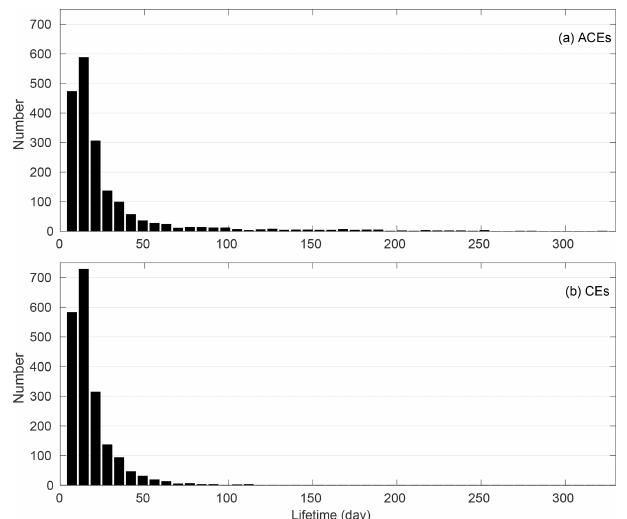
Figure 3. Number of (a) anticyclonic eddies (ACEs) and (b) cy- clonic eddies (CEs) from 1993 to 2016, plotted as a function of their lifetime. Eddies with lifetimes shorter than 7d were excluded from the analysis. The bin width for eddy lifetime is 7d.